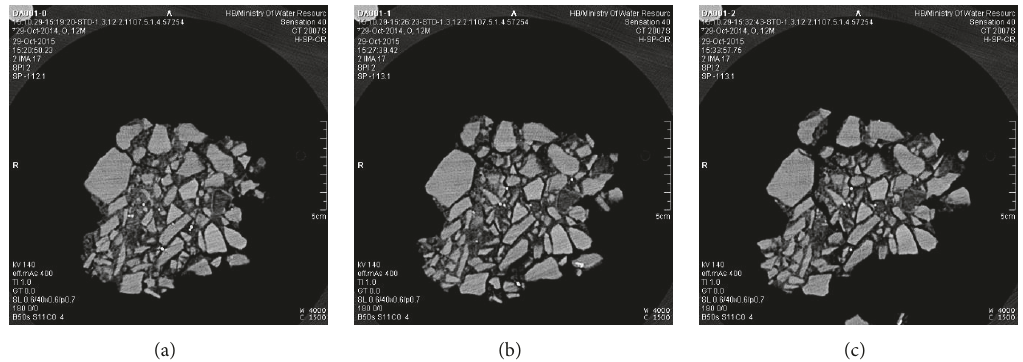
Figure 6: CT scan results for a cracked cross section of the 40-year sample at the same location for different compression times.